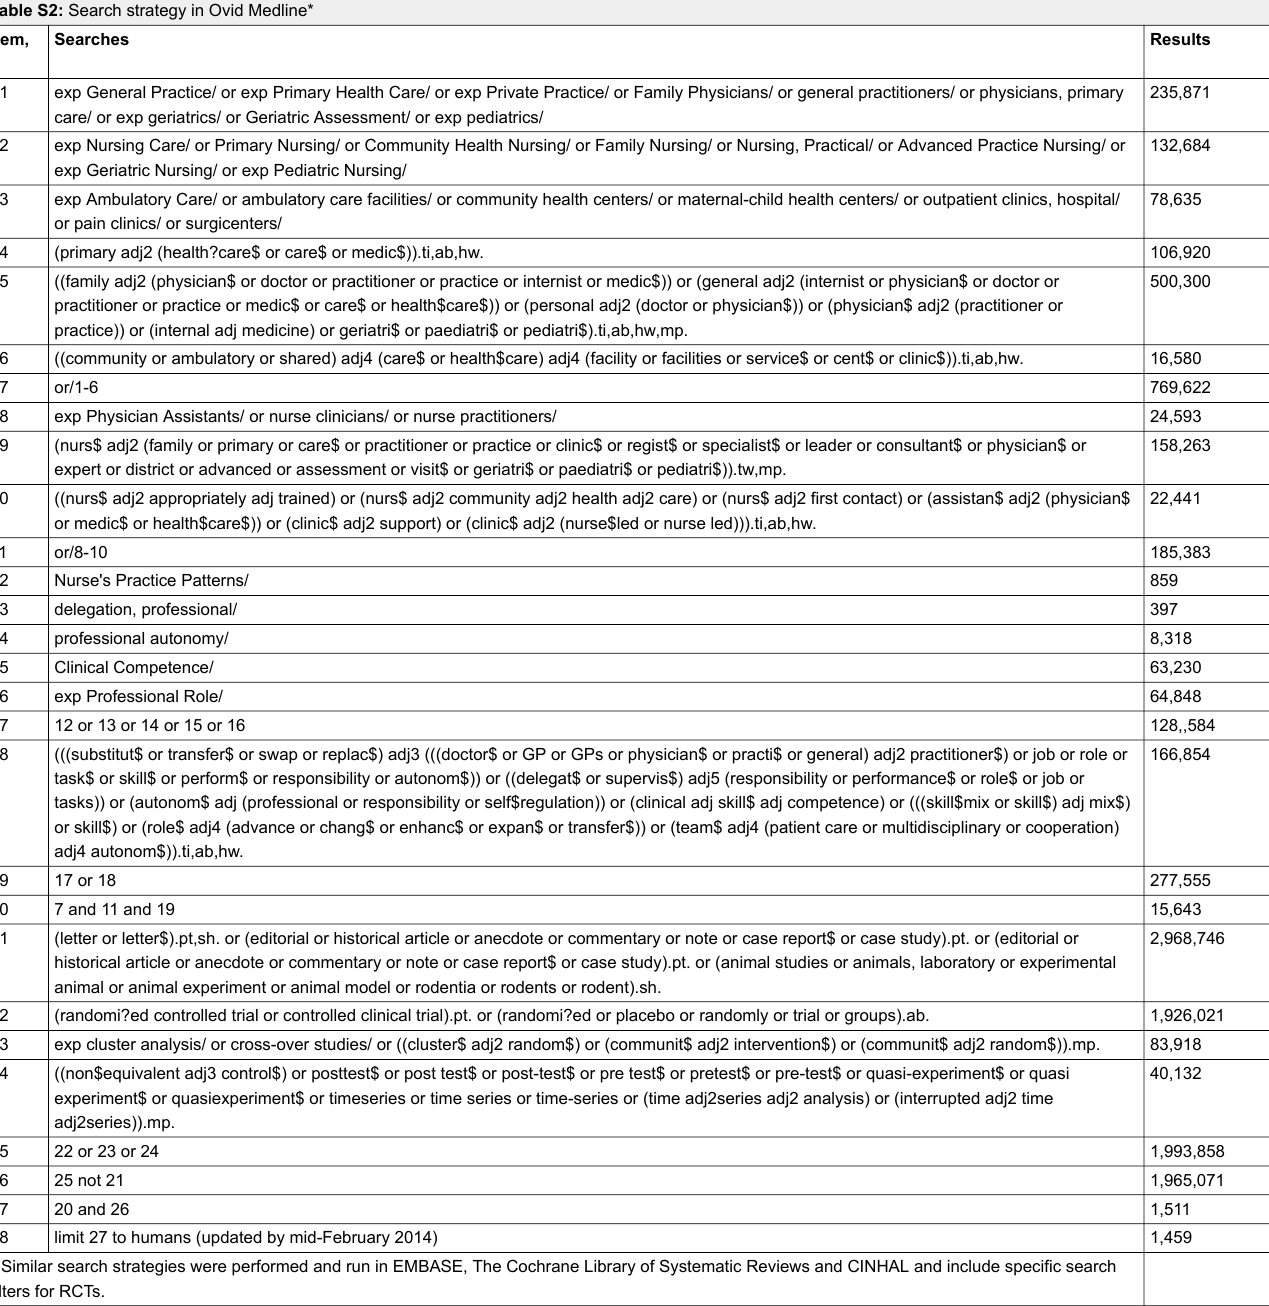
Table S2: Search strategy in Ovid